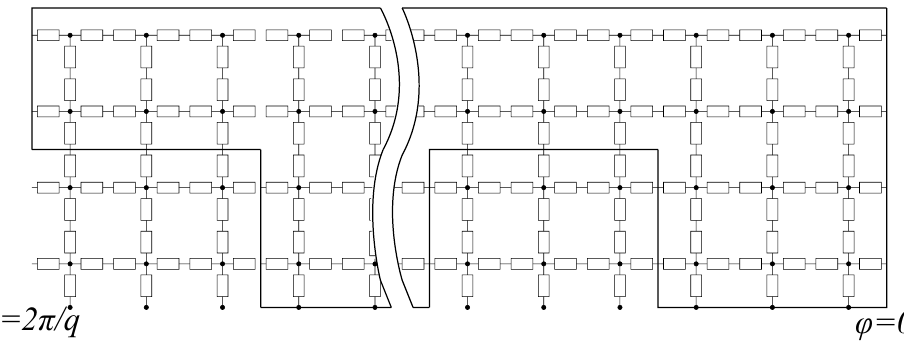
Figure 3. Reluctance network in the